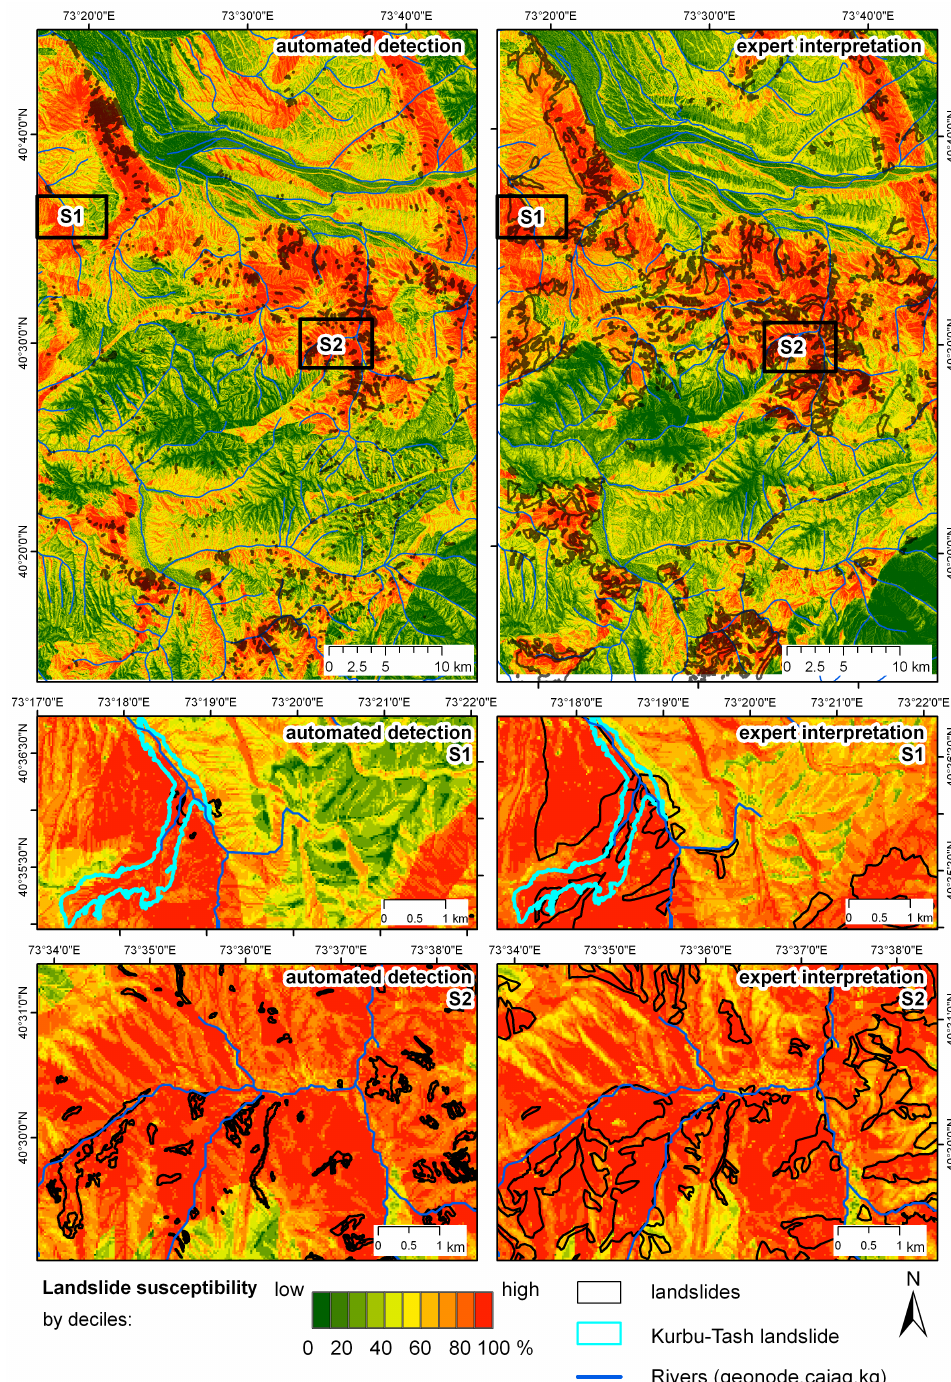
Figure 4. Results of susceptibility assessment produced using automatically detected landslide masses (1986–2016) and landslides obtained by expert interpretation: study area and two